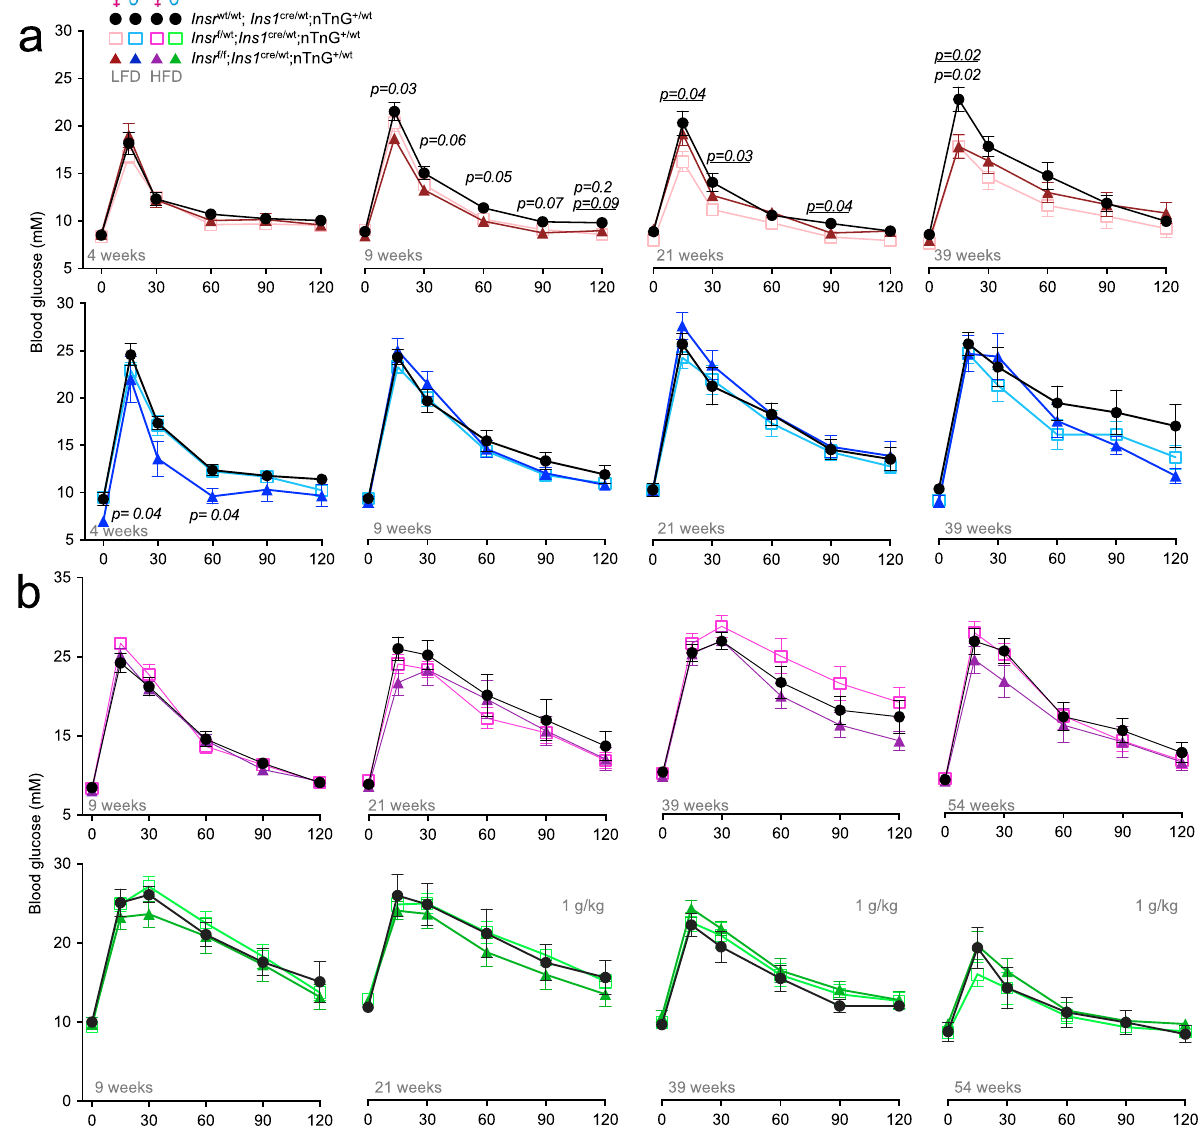
Fig. 7 Glucose tolerance at multiple ages in β -cell speci fi c Insr knockout mice fed 2 different diets. a Tail blood glucose levels (mM) from glucose tolerance tests of LFD-fed females (control (black lines, solid circles), β Insr HET (light pink, open squares), β Insr KO , (dark red lines, solid triangles)); ( n 4week = 16, 16, 14; n 9week = 23, 25, 17; n 21week = 12, 15, 12; n 39week = 8, 12, 10) and males (control (black lines, solid circles), β Insr HET (light blue, open squares), β Insr KO (male = dark blue, solid triangles); ( n 4week = 10, 18, 5; n 9week = 17, 30, 11; n 21week = 8, 14, 8; n 39week = 9, 7, 13). b Tail blood glucose levels (mM) from glucose tolerance tests of HFD-fed female (control (black lines, solid circles), β Insr HET (bright pink, open squares), β Insr KO (purple lines, solid triangles)); ( n 9week = 17, 17, 14; n 21week = 12, 14, 12 n 39week = 14, 16, 10; n 54week = 10, 13, 11) and male (control (black lines, solid circles), β Insr HET (bright green, open squares), β Insr KO (dark green lines, solid triangles)); ( n 9week = 7, 16, 9; n 21week = 7, 16, 8; n 39week = 8, 14, 8; n 54week = 6, 11, 7) mice. All mice received a glucose bolus of 2 g glucose/kg body mass (i.p) except older HFD-fed males, which received only 1 g glucose/kg body mass (i.p ). * p -values are italicized when β Insr KO was compared to controls, p -values are italicized and underlined when β Insr HET was compared to controls. Data were analysed by a fi tted mixed-effects model with correction for multiple comparisons using Dunnett ’ s method. All animals/samples were handled in a strictly blinded manner. All data are presented as mean values ± SEM. Source data are provided as Source Data fi and impairs the sympathoadrenal response to hypoglycemia 48 , while Insr knockout using AgRP Cre results in abnormal sup- pression of hepatic glucose production 49 . Our β Insr KO mouse line is the most tissue speci fi c model used to date for the study of autocrine insulin signaling and β -cell insulin resistance.